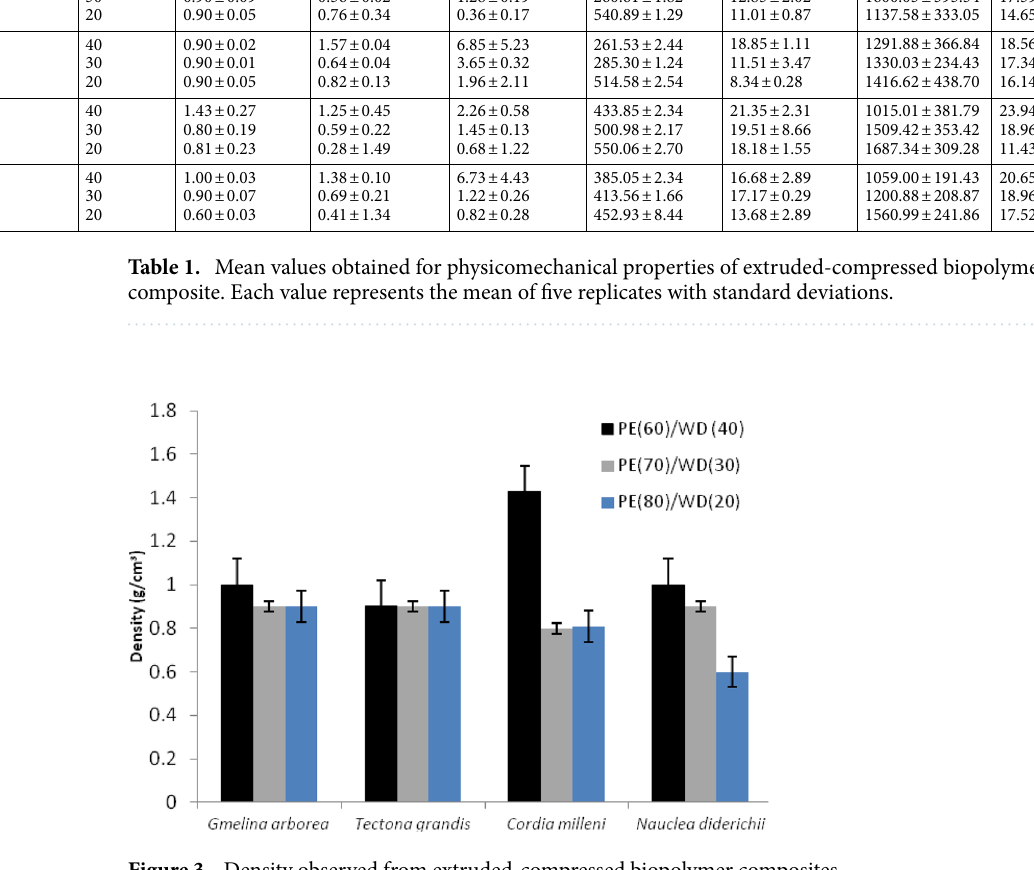
Figure 3. Density observed from extruded-compressed biopolymer